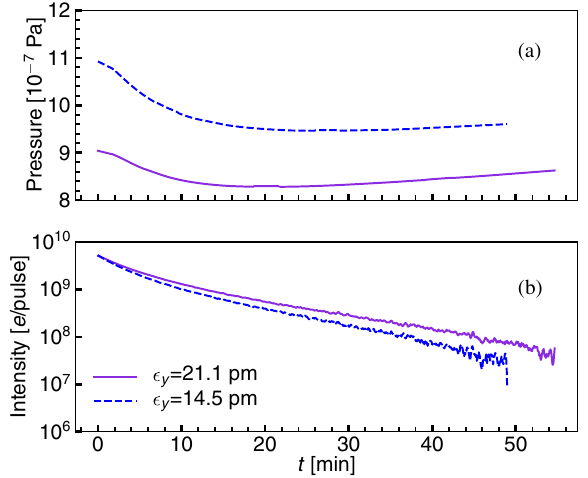
FIG. 3. Evolution of the averaged gas pressure (a) and current decay of the stored beam (b) in the ATF damping